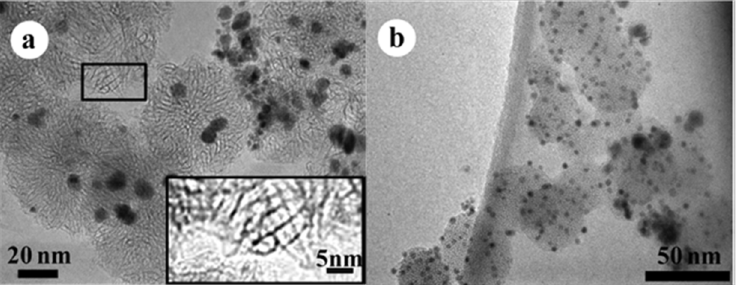
Figure 2. TEM images of ( a ) Pd-Pt/SWCNHs and ( b ) Pd-Au/SWCNHs synthesized by the GI-AIW method. The inset (in Figure 2a) resolves the horn structures of SWCNHs. Reproduced with permission of [40]; American Chemical Society,